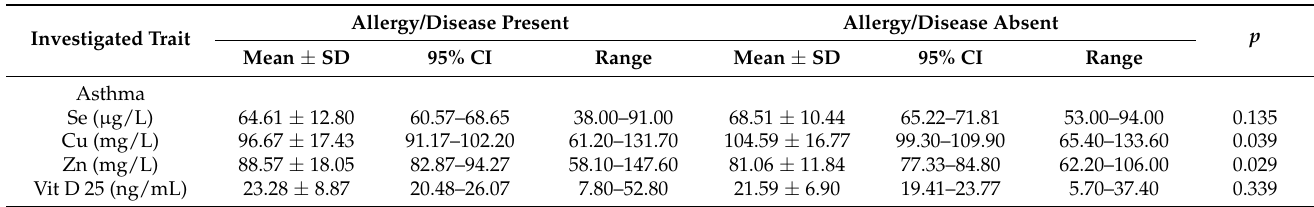
Table 2. Comparison of blood concentrations of Zn, Se, Cu, vitamin D, vitamin A and vitamin E in patients with asthma, allergic rhinitis, atopic dermatitis, food allergy and HDM